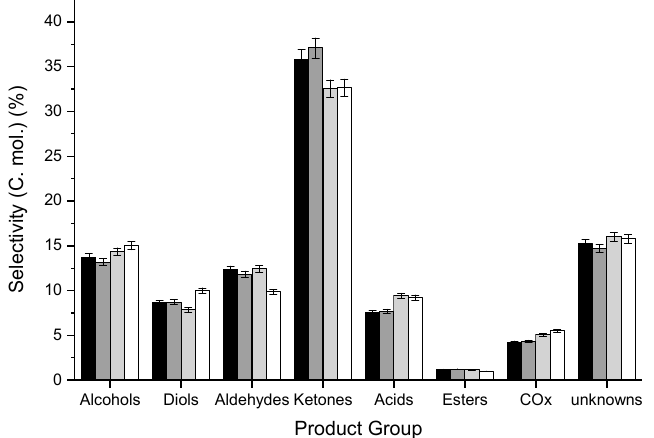
Figure 5. The product group selectivity over CeO 2 calcined at different temperatures where the catalyst mass and Ar flow rate has been adjusted to maintain a consistent catalyst bed surface area; (black bar), 500 ◦ C (dark grey), 600 ◦ C (light grey) and 700 ◦ C (white bar). Reaction conditions; 340 ◦ C, 400 °C (black bar), 500 °C (dark grey), 600 °C (light grey) and 700 °C (white bar). Reaction conditions; 50 wt.% Gly/H 2 O, GHSV ca. 3450 h − 1 340 °C, 50 wt.% Gly/H 2 O, GHSV ca. 3450 h − 1 .